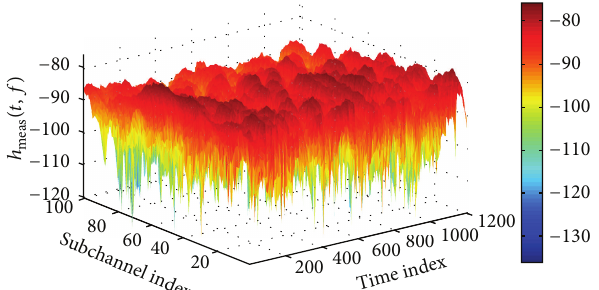
Figure 2: An illustration of one measured channel ℎ meas (𝑡,𝑓) . The channel was sampled at 60 Hz in the time